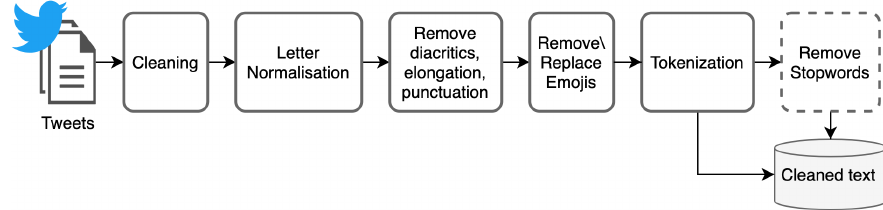
Figure 1. Preprocessing steps.